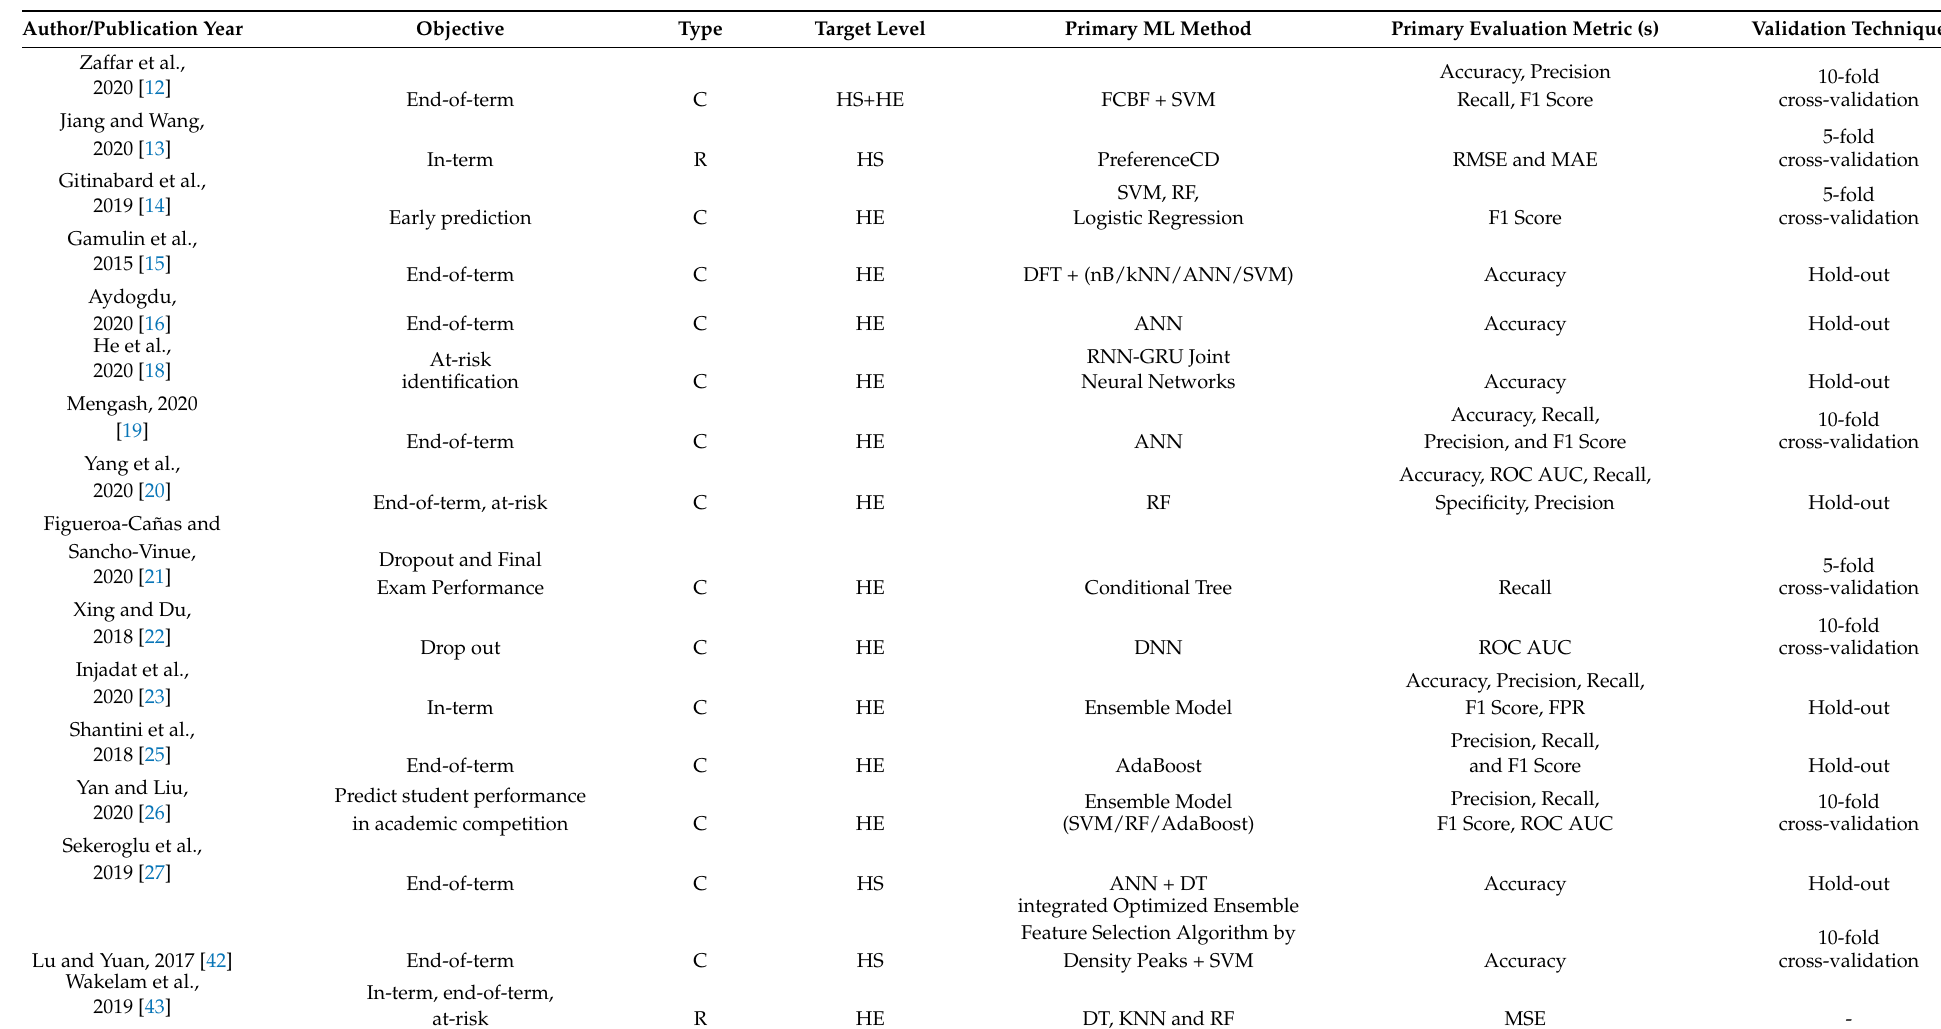
Table 2. Characteristics of the selected